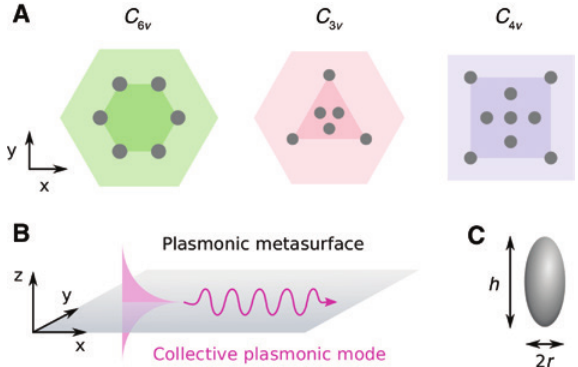
Figure 1: Set up of the